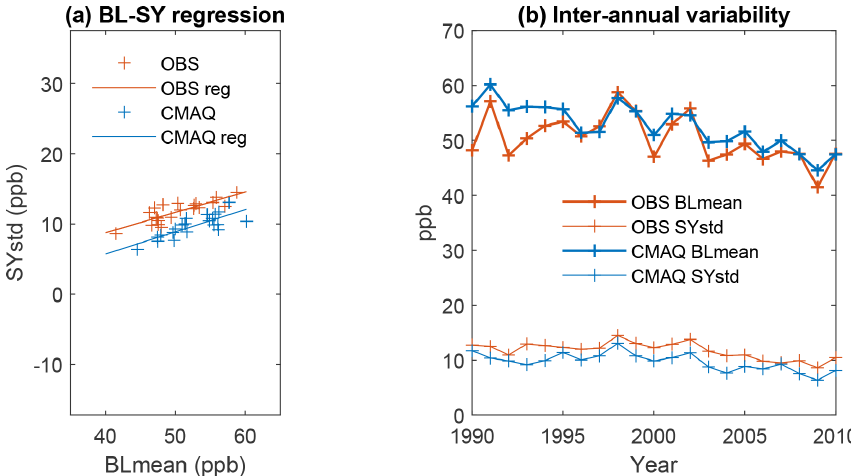
Figure 6. (a) Scatter plot of the standard deviation (i.e., strength) of the synoptic (SY) component vs. the mean of the baseline (BL) component for each of the 21 years from 1990 to 2010 at the Altoona, PA, monitoring site. Observations are shown in red, while WRF- CMAQ results are shown in blue. (b) Inter-annual variability in the mean of the baseline component and standard deviation of the synoptic component in the WRF-CMAQ model and observations at the Altoona, PA, site. Although year-to-year variation is captured, the model has overestimated the baseline forcing and underestimated the synoptic